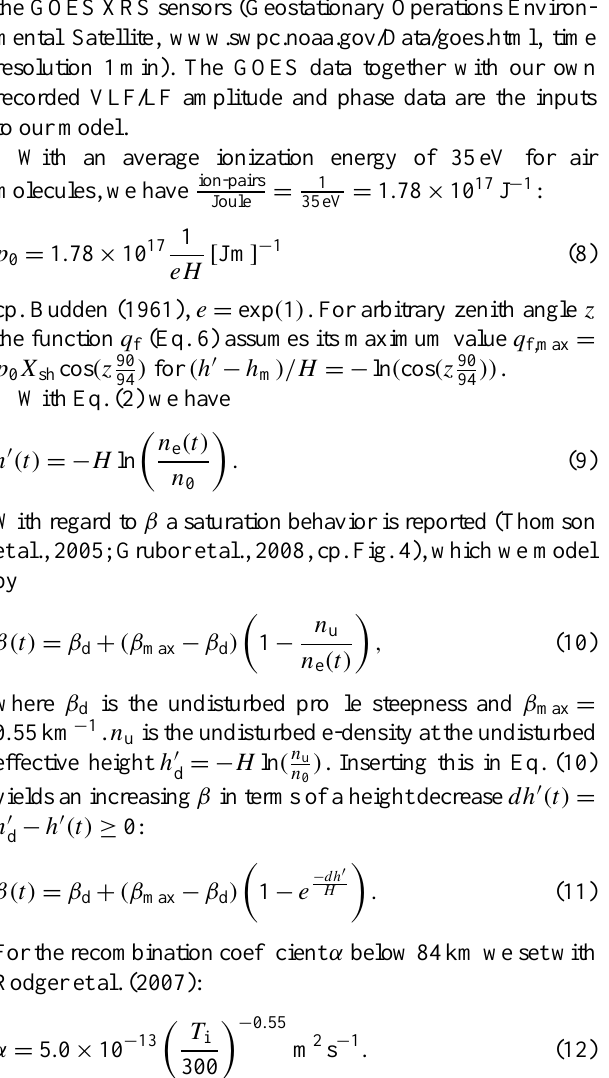
Fig. 3. height decrease vs. X-flux (0.05–0.4nm). Sun zenith angle z =